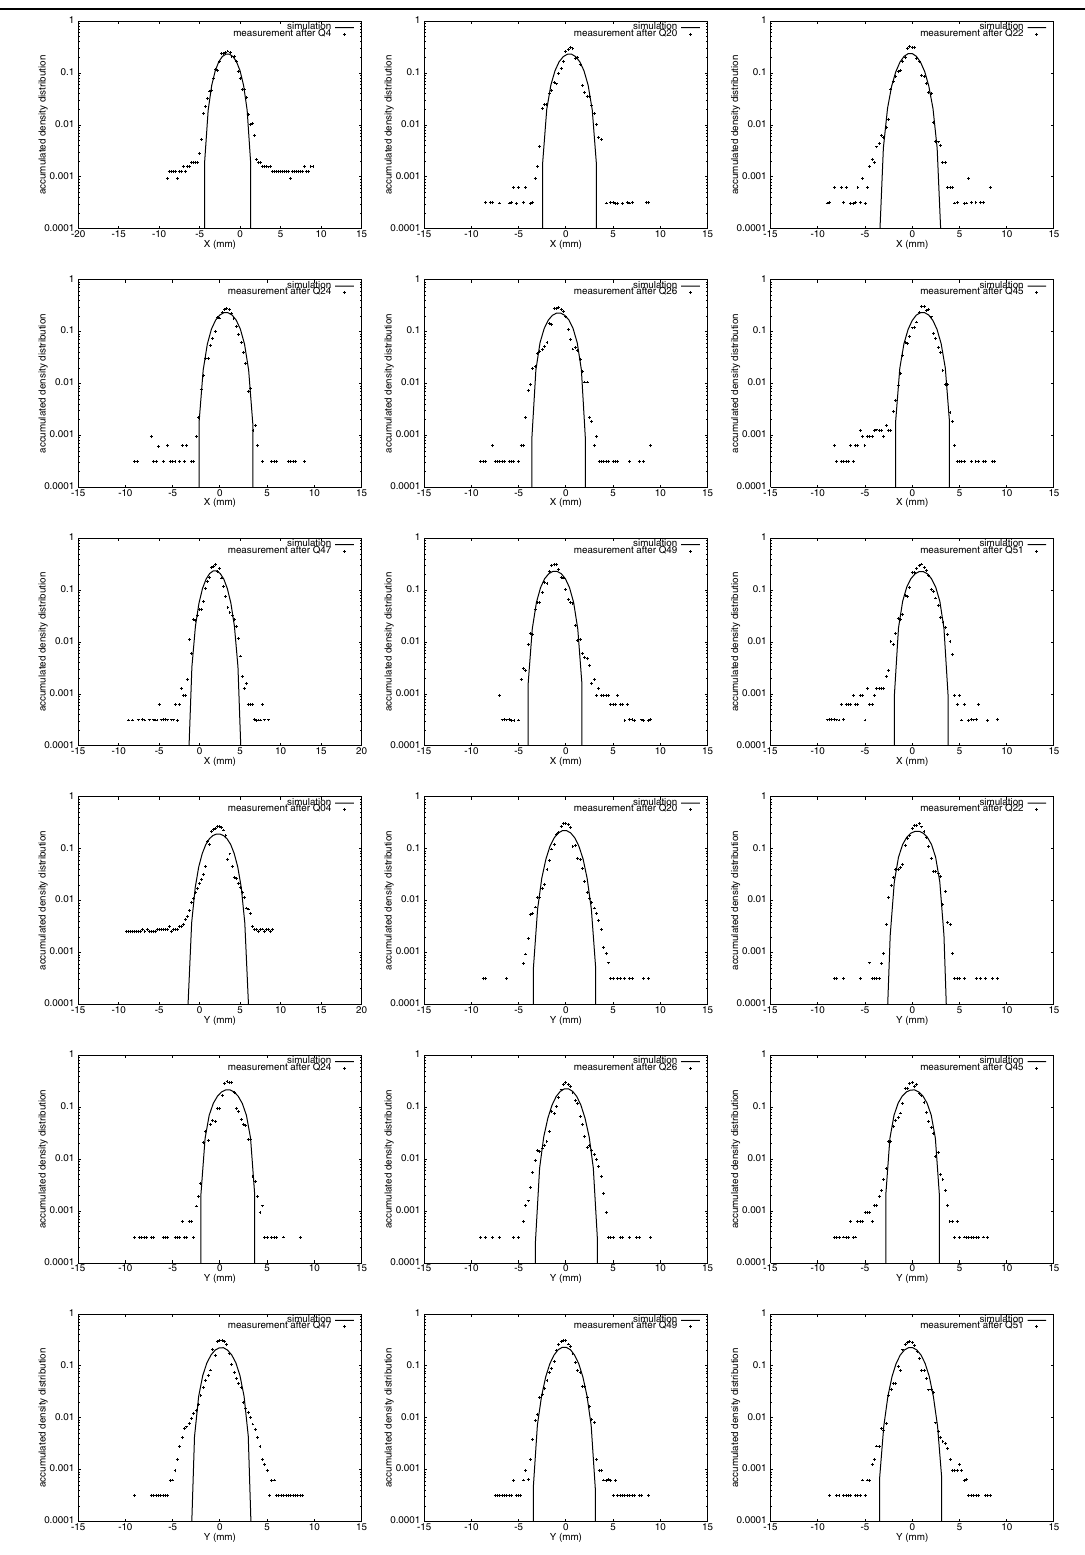
FIG. 4. X and y density distribution from simulation using initial Waterbag distribution and from measurements at 75 mA matched case. The first nine plots correspond to the nine x profiles and the second nine plots correspond to the nine y